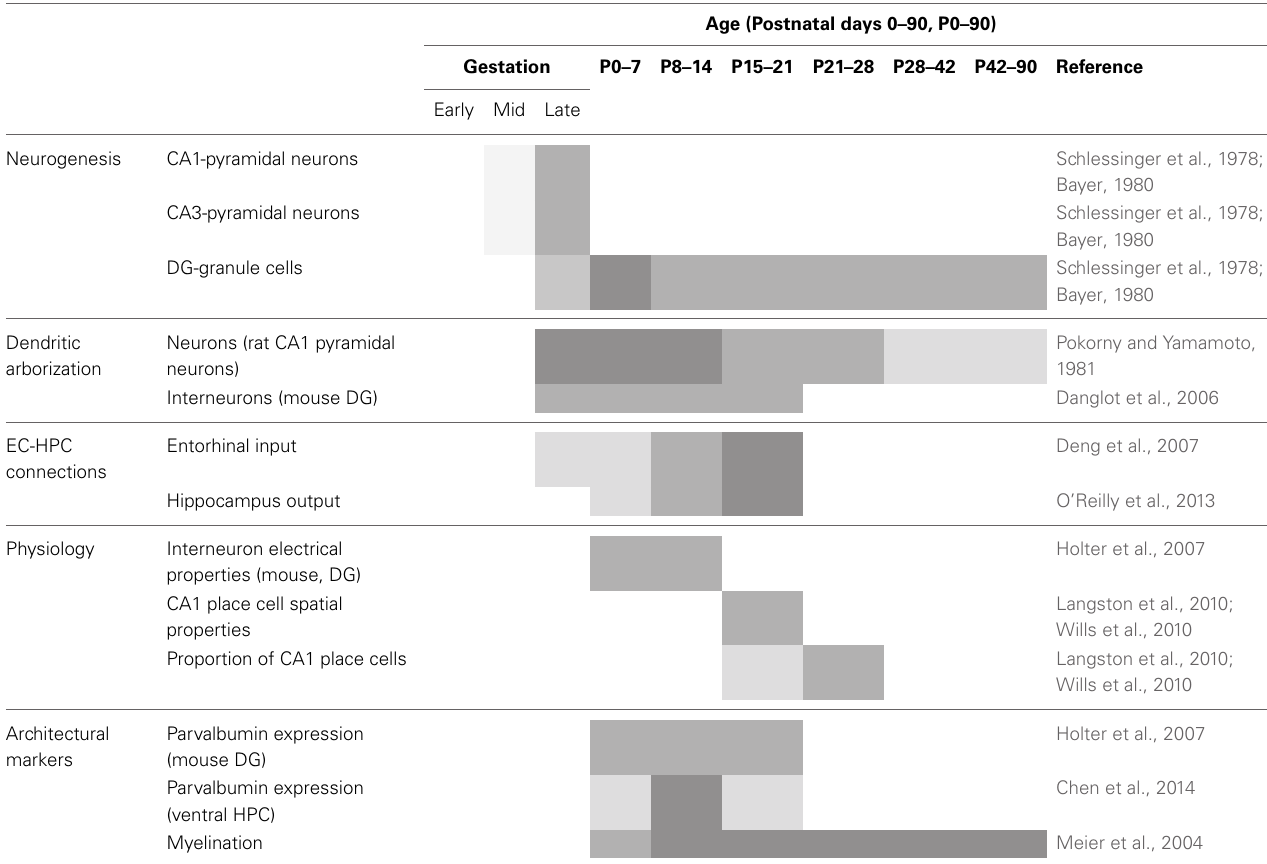
Table 1 | Prolonged developmental processes of the hippocampal region in rodents.